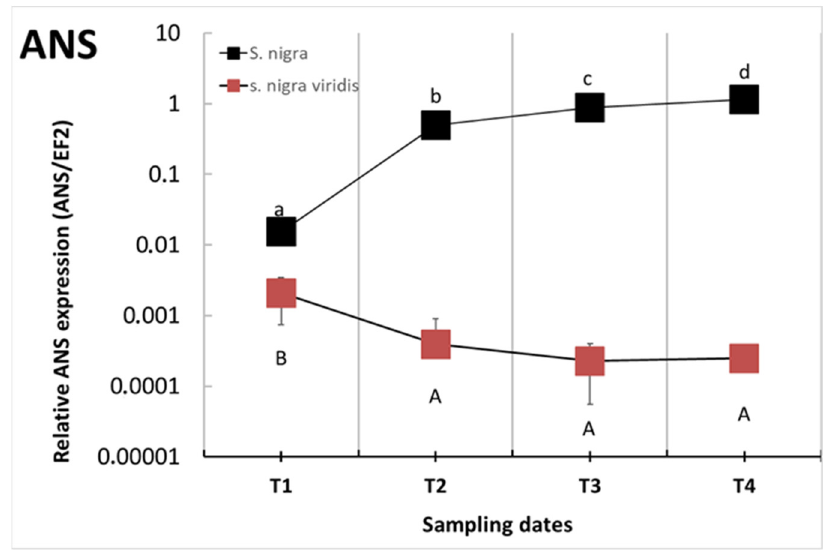
Figure 6. Expression level of ANS in NIGRA (■) and VIRIDIS (■) berries during different develop- mental stages (T1–T4). Quantitative expression was normalized to elongation factor 2 . The y -axis shows a logarithmic scale to better visualize the differences between NIGRA and VIRIDIS. A non-logarithmic version is provided in Supplementary Figure S1, Different small letters (a–d) denote statistically significant differences between developmental stages for the NIGRA genotype, and different capital letters (A–B) denote statistically significant differences between developmental stages for the VIRIDIS genotype, obtained with the Duncan test ( p < 0.05). Data are presented as average value ± standard error ( n = 4).